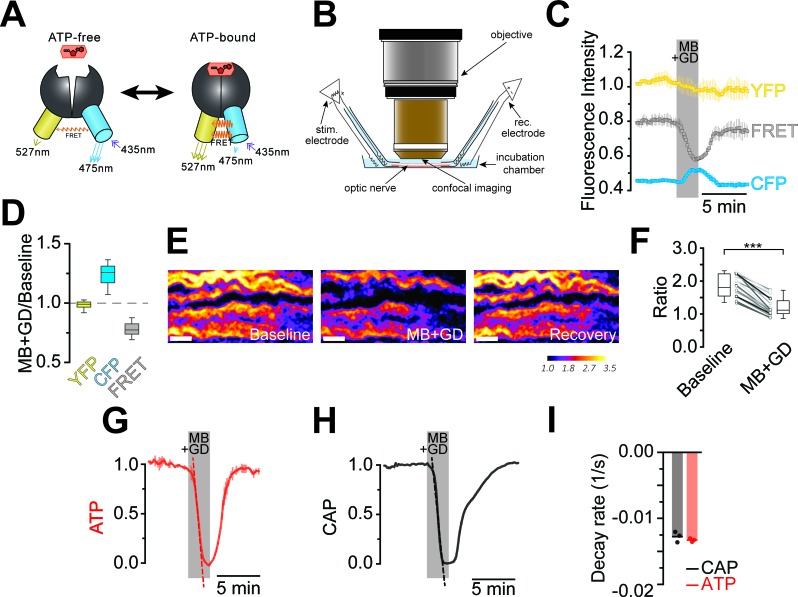
Imaging of ATP combined with electrophysiology in acutely isolated optic nerves of ThyAT-mice.(A) Binding of ATP induces a conformational change in the genetically encoded ATP-sensor ATeam1.03YEMK thus increasing the FRET effect (YFP emission upon CFP excitation) and simultaneous decreased emission of CFP (upon CFP excitation). The ratio between FRET and CFP can thus be correlated with the concentration of ATP present in the cell. (B) Schematic representation of the set-up to acquire evoked CAPs in the optic nerve and to simultaneously investigate relative ATP levels by electrophysiology and confocal imaging, respectively. (C) Time course of fluorescence intensity recorded in the YFP, FRET and CFP- channels during application of mitochondrial blockage (MB) and glucose deprivation (GD) for 2.5 min. Values are normalized to YFP intensity prior to application of MB+GD (n = 3 nerves). Time resolution: 10.4 s. (D) The combination of MB and GD is a fast and reliable way to deplete ATP in axons of the optic nerve. ATP depletion is measured as a decrease in FRET and increase in CFP, calculated as ratio between fluorophore intensity during MB+GD, over fluorophore intensity at baseline condition (MB+GD/Baseline). Notably, YFP emission upon YFP excitation remains unchanged (n = 5 nerves). (E) Ratiometric images displaying the FRET/CFP ratio of the ATeam1.03YEMK–sensor in the axons of the optic nerve during ATP depletion following MB+GD. The phases before (Baseline) and after (Recovery) are also shown. Scale bar: 10 μm. (F) FRET/CFP ratio values (not normalized) during baseline and MB+GD. The boxplots show summarized data of n = 19 nerves, lines in between boxplots show changes in the FRET/CFP ratio of all 19 individual nerves (***p<0.001). (G) To assess ATP variations, the ratio of the fluorescence intensities of the FRET and CFP-channel was calculated (FRET/CFP ratio) and normalized to baseline (set as 1) and MB+GD (set as 0). The red dashed line visualizes the slope of ATP drop at the point of maximal velocity of ATP decay during mitochondrial blockage (MB+GD, n = 3). (H) Recording of the evoked compound action potential (CAP), given as the normalized curve integral during mitochondrial blockage and glucose deprivation (MB+GD). The black dashed line represents the slope at the point of maximal velocity of CAP changes during MB+GD treatment (n = 3). Individual CAP traces are shown in Figure 3—figure supplement 1. (I) Stripe plot describing CAP (black) and ATP (red) kinetics, expressed as maximal variation per s, during MB+GD (p=0.39, n = 3, Welch’s t-test). Dots show individual data points, bars and lines represent the mean of all data.DOI:
http://dx.doi.org/10.7554/eLife.24241.00410.7554/eLife.24241.005Figure 2—source data 1.Table containing data for Figure 2.This xlsx-data file contains the data shown in Figure 2D,F and I.